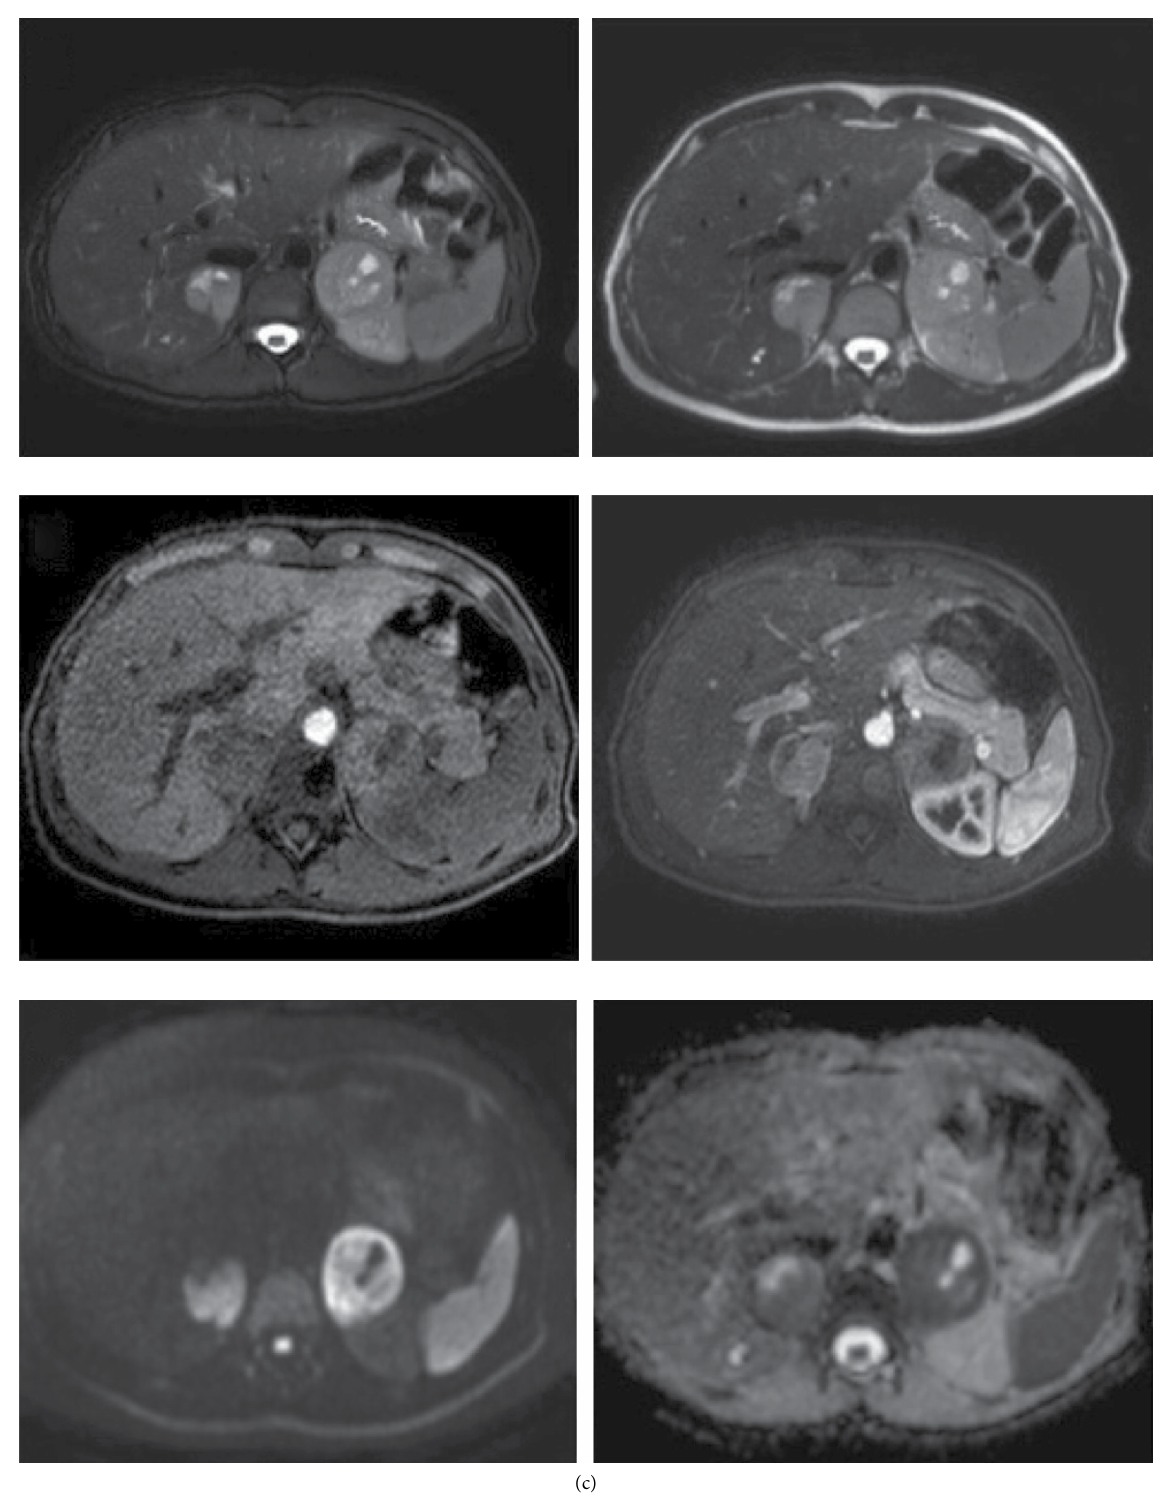
Figure 1: Abdominal MRI scan showing bilateral phaeochromocytoma. (a) axial TSE-T2W images with and without fat suppression; (b) axial GRE-T1W images prior to and 35 s after contrast injection; (c) DWI and ADC map showing restricted diffusion (ADC = 0.6 × 10 −3 mm 2